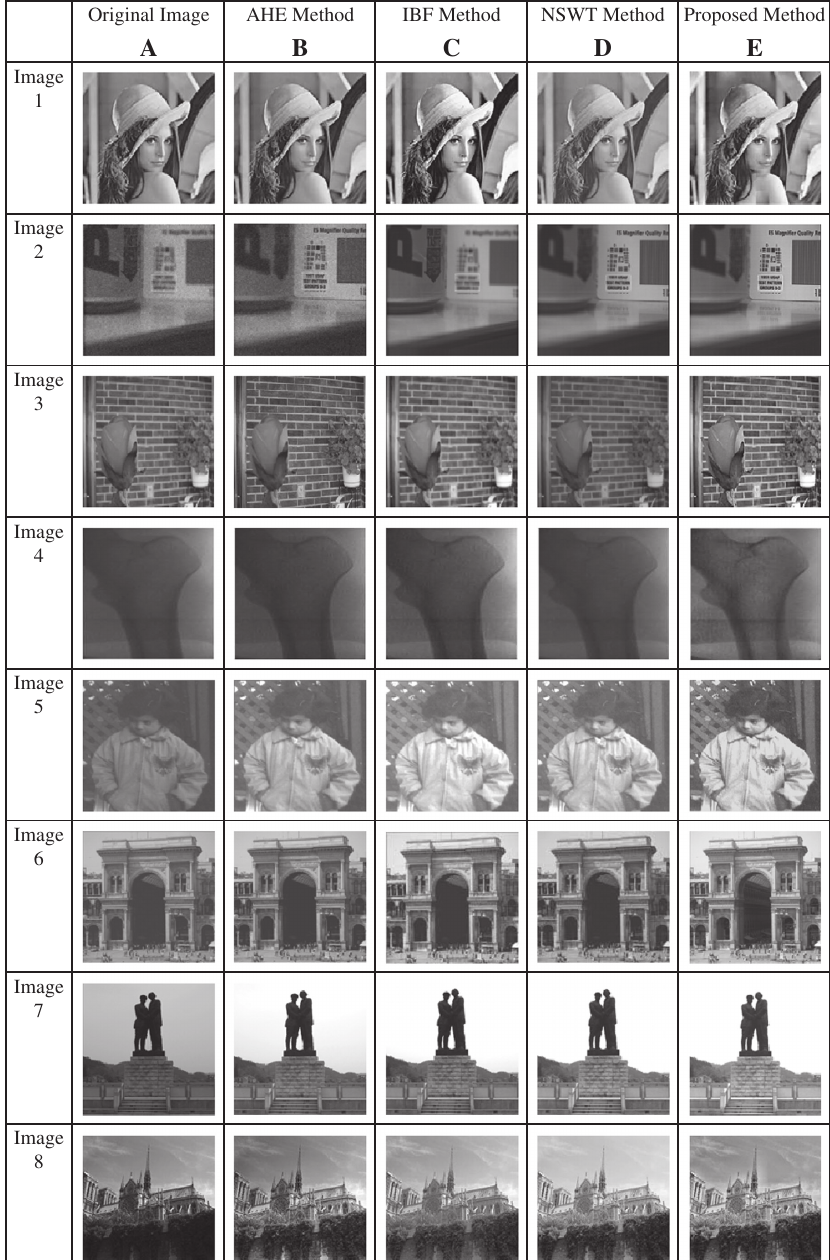
Figure 5. Comparison of Different